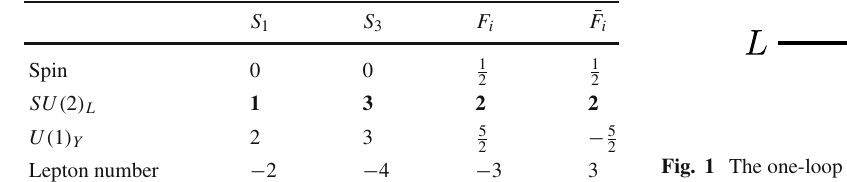
Table 1 The BSM fields and their quantum numbers in Model-1. The index i ( = 1 , 2 , 3) distinguishes the three copies of ( F , ¯ F ) fields. Since lepton number is broken in the model, the lepton number assignment in this table should be understood as being valid in the limit λ 5 → 0, see